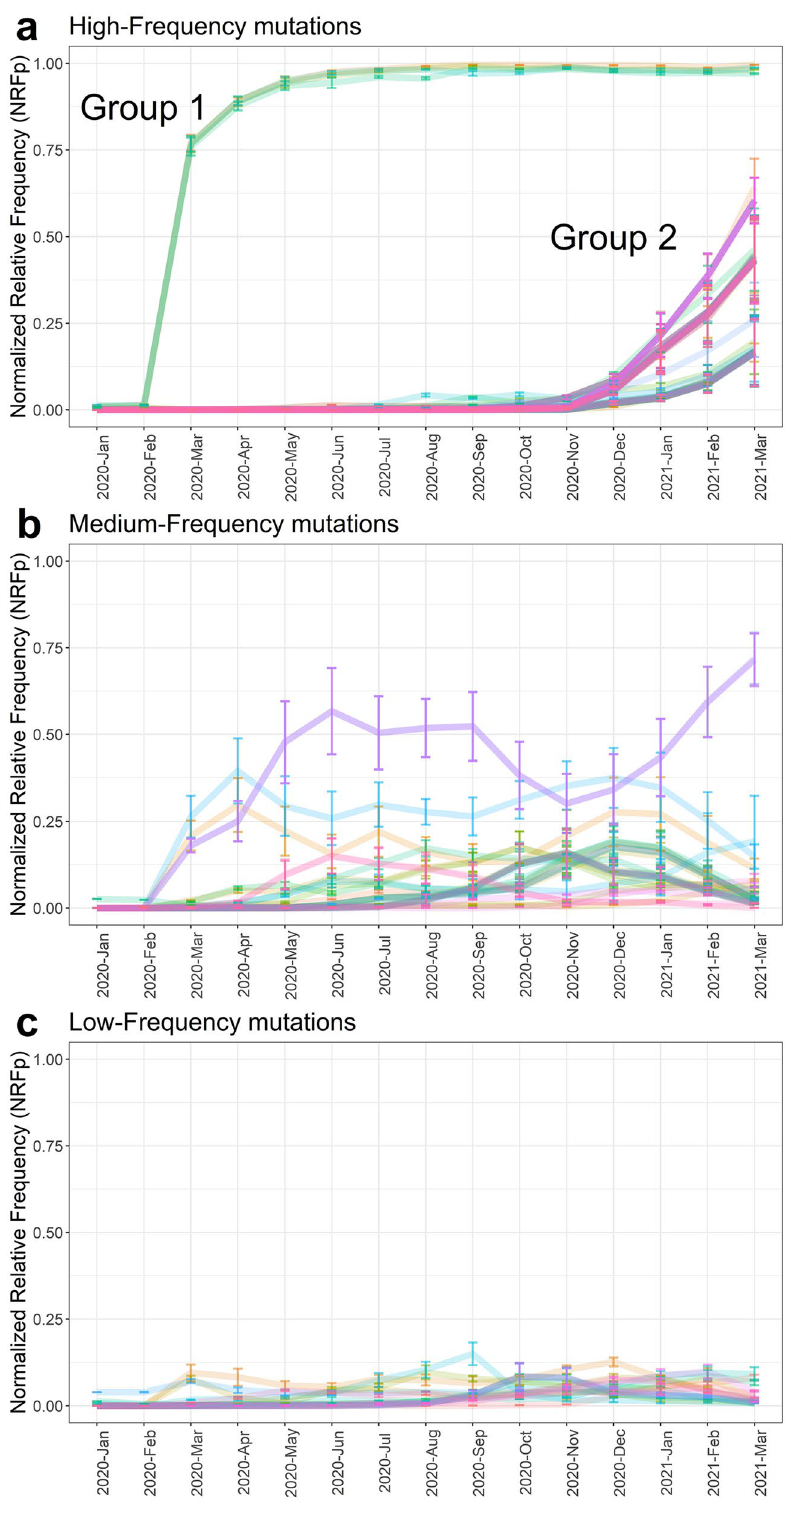
Figure 1. Three different temporal dynamics of SARS-CoV-2 mutations. Normalized by cases Relative Frequency (NRFp) of the mutations by month. (a) high-frequency mutations (HF) never show negative NRFp changes greater than 1%, and increased rapidly since their appearance. (b) medium-frequency mutations (MF) alternates between negative and positive NRFp changes and presents at least one month with NRFp greater than 15% (c) low-frequency mutations (LF) that also have an alternation between negative and positive NRFp changes but at a NRFp ever below 15%. Error bars represent inter-region variation as weighted